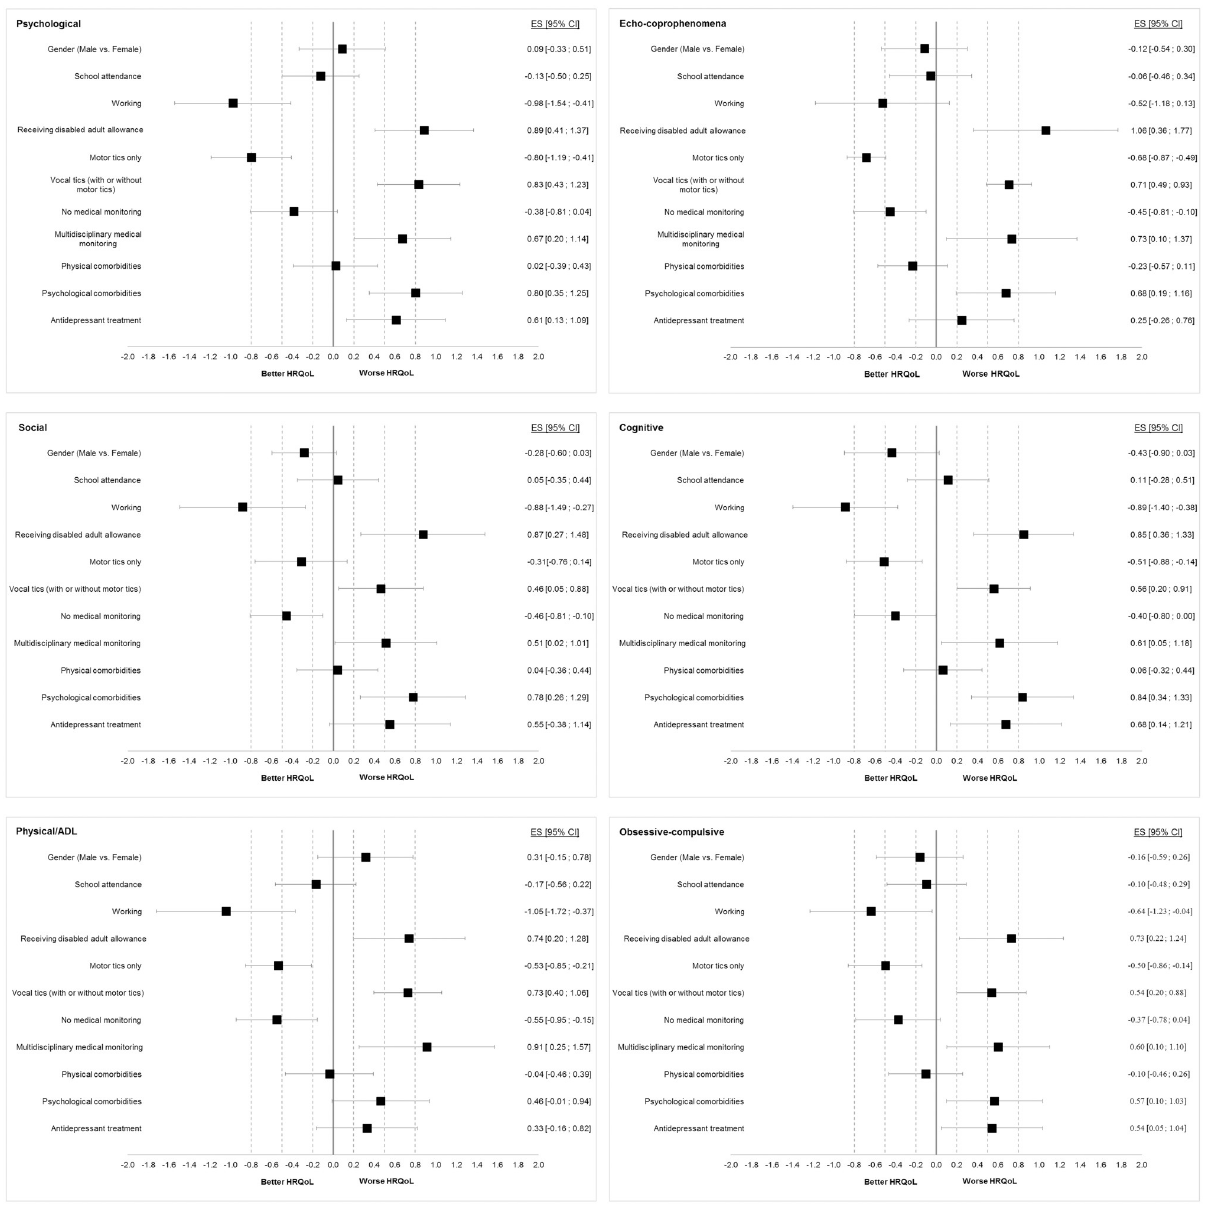
Fig 1. Effect size of sociodemographic and clinical factors on GTS-QOL-French subscales. Effect sizes (ES) are presented as forest plot with 95% confidence interval [95% CI] for each GTS-QOL-French subscale. Except for gender, the ES are given for ‘Yes’ versus ‘No’ values of the sociodemographic and clinical factors. Positive ES indicates worse health-related quality of life (HRQoL) and negative ES better HRQoL. Dotted lines represent the threshold for small (0.2), moderate (05) and large (0.8) ES.